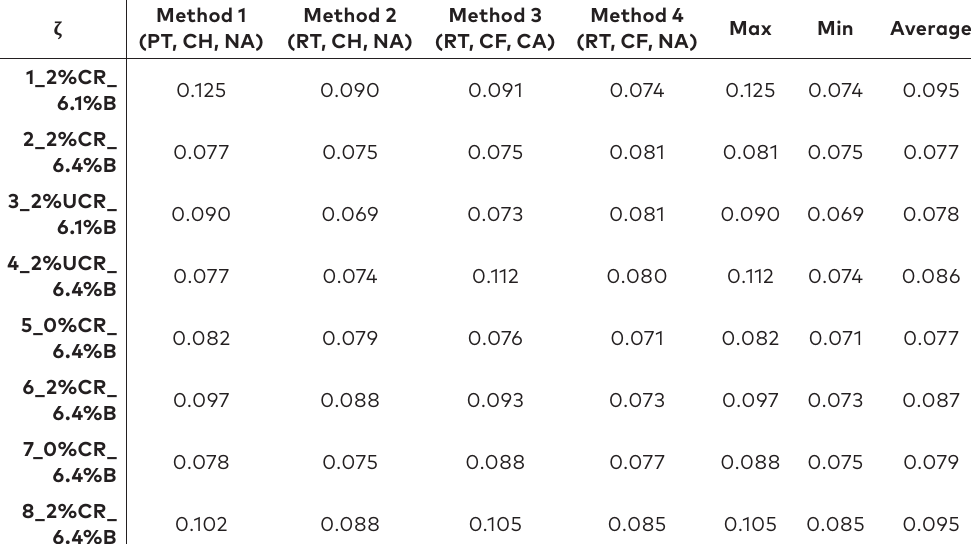
Table 13. Damping ratio derived using different